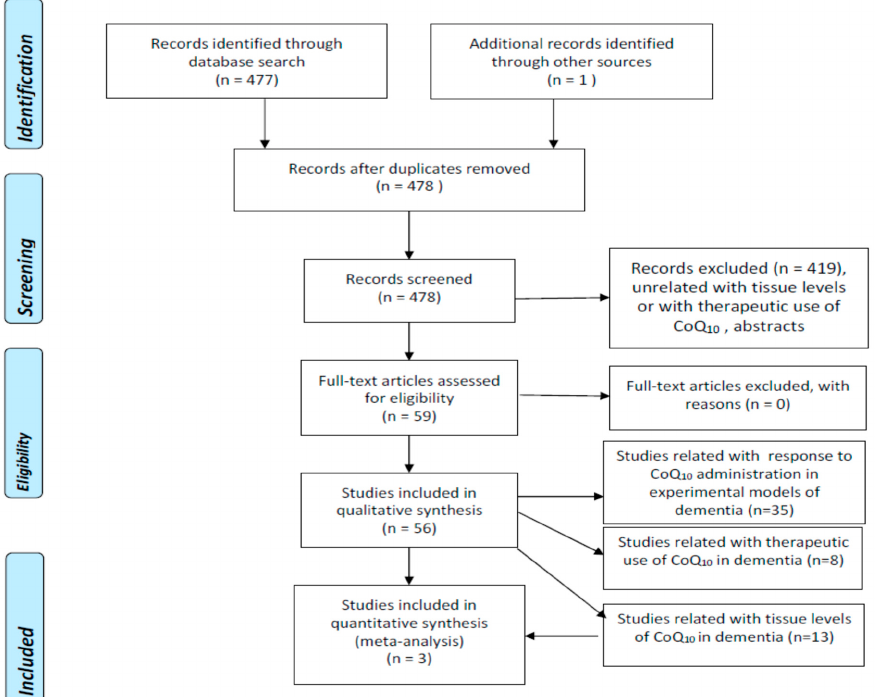
Figure 1. Flowchart for studies assessing tissue concentrations of coenzyme Q10 in dementia (PRISMA) (6, 17). (PRISMA) (6,